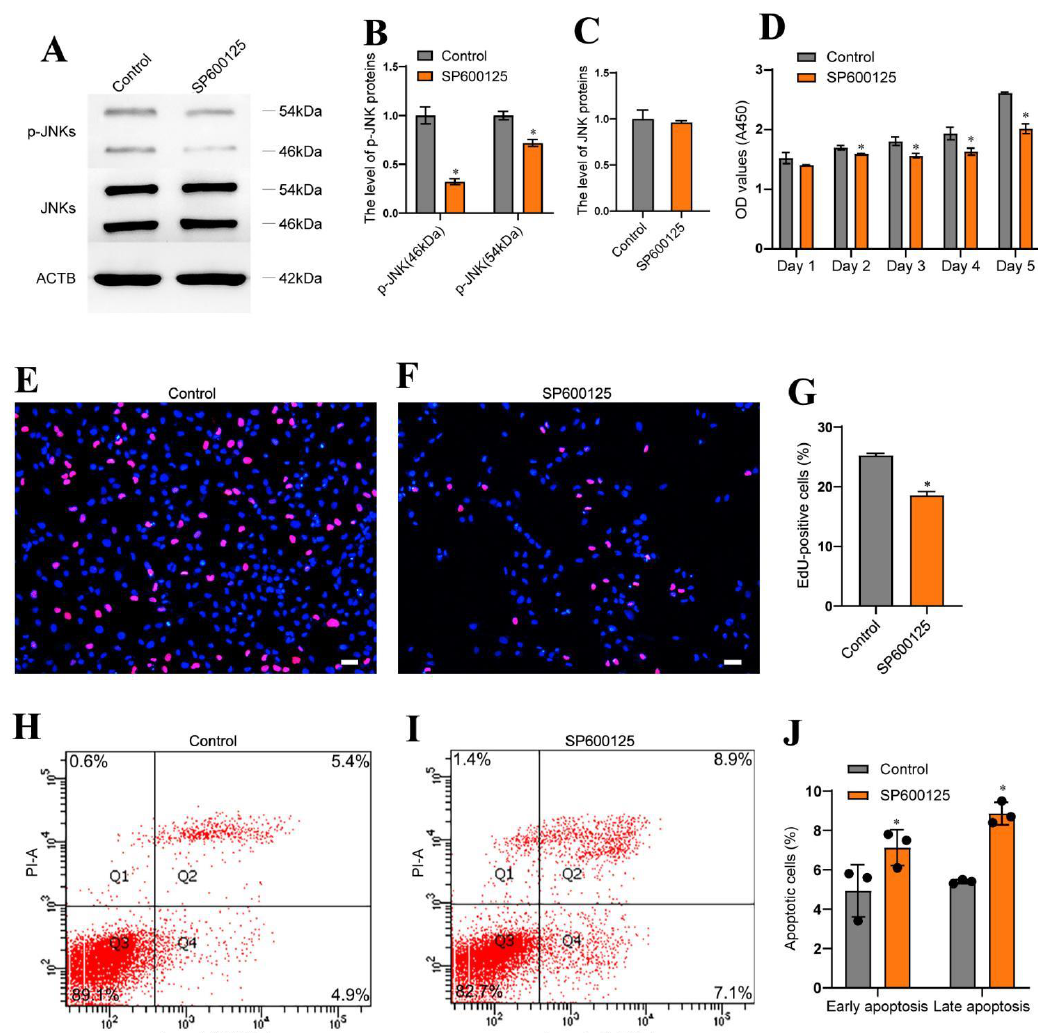
Figure 5. Inhibition of JNK phosphorylation decreased human SSC proliferation and enhanced their apoptosis. ( A – C ) Western blotting showed that the phosphorylation of JNKs was significantly decreased in human SSC line by the JNKs phosphorylation inhibitor SP600125. ( D ) CCK-8 assay dis- played the proliferation of human SSC line after treat with SP600125 from day 1 to day 5. ( E – G ) EdU